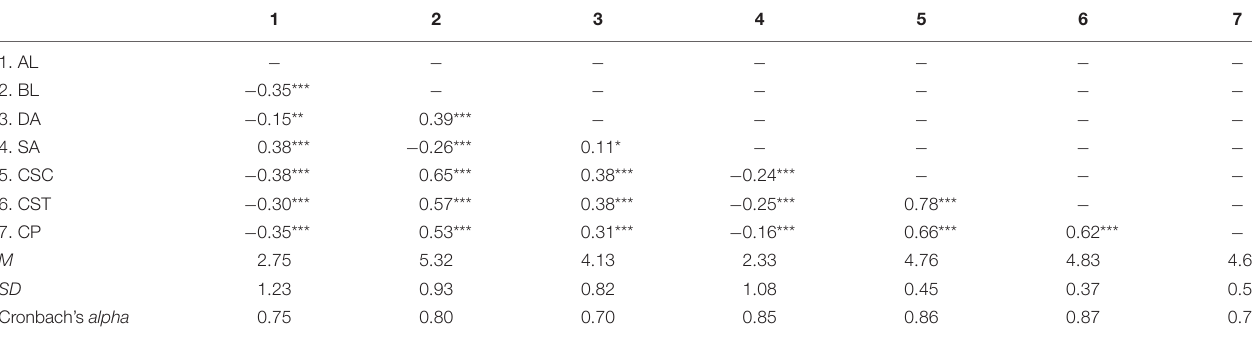
TABLE 1 | Descriptive statistics, Cronbach’s α , and correlation matrix.